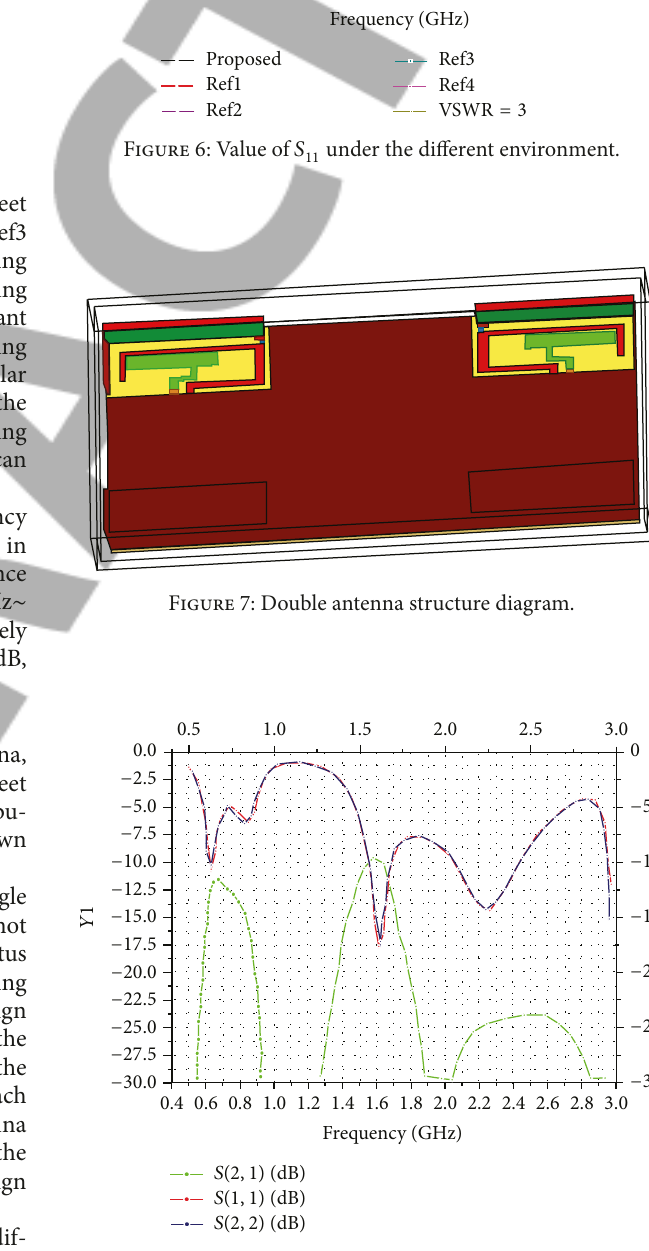
Figure 8: 𝑆 parameter of the design